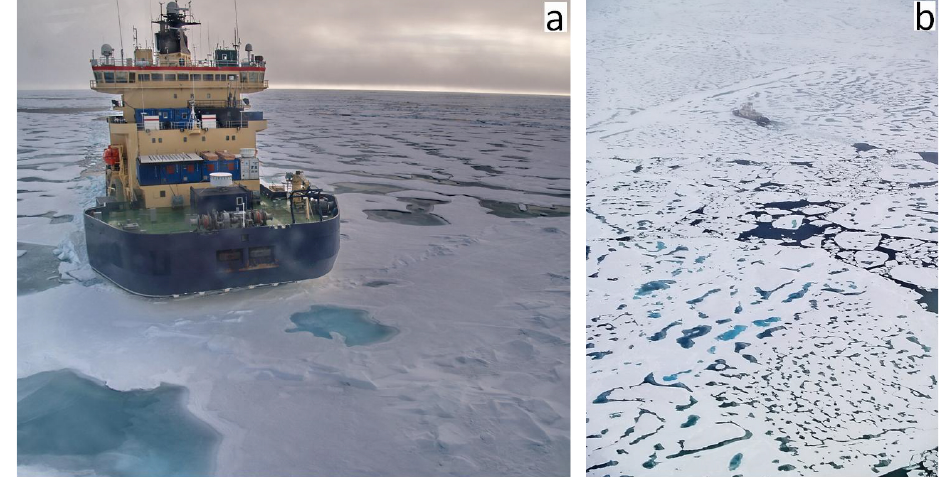
Fig. 3. Photographs from 11 August, 2008, of the icebreaker Oden (a) from the front, and (b) from above embedded in a large ice floe. Note the numerous melt ponds on the ice. Both photographs were taken somewhat south of 87 ◦